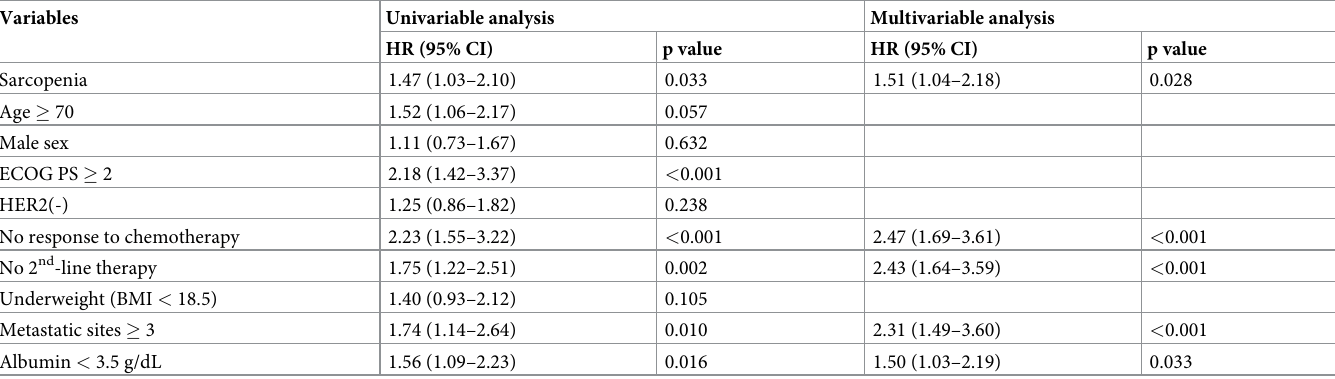
Table 2. Results of univariable and multivariable analyses of overall